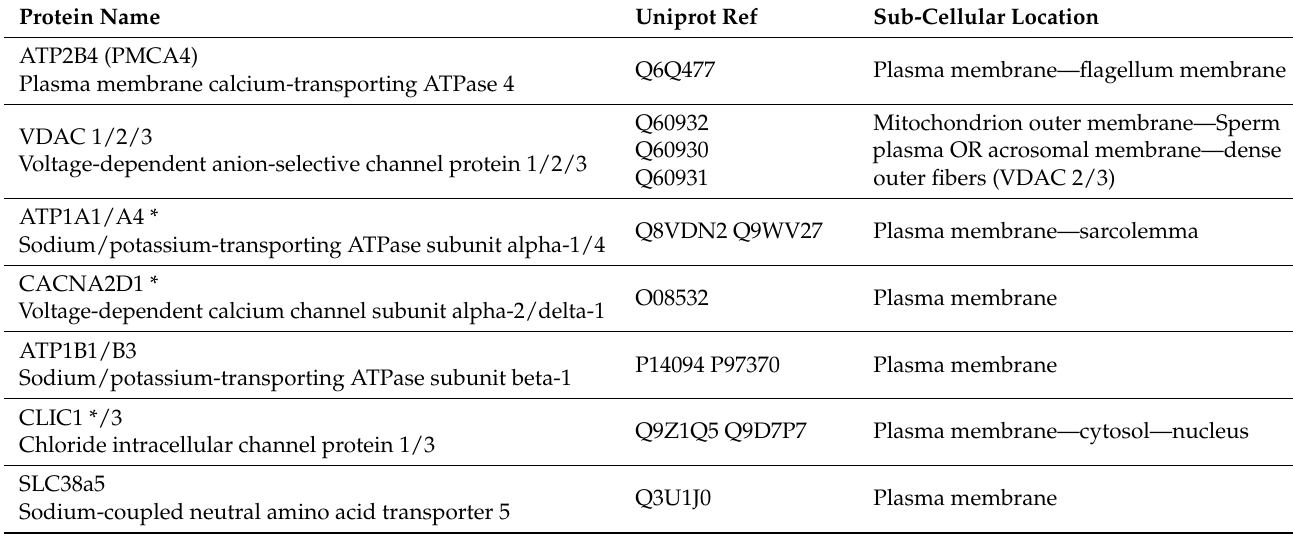
Table 3. Proteins identified by proteomic analyses in both epididymal spermatozoa [170] and mouse epididymosomes [172]. * Proteins are also present in human prostasomes